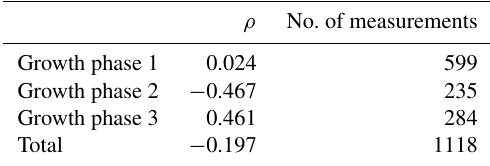
Table 2. Pearson’s coefficient of correlation ( ρ ) calculated for the three growth phases and for the total